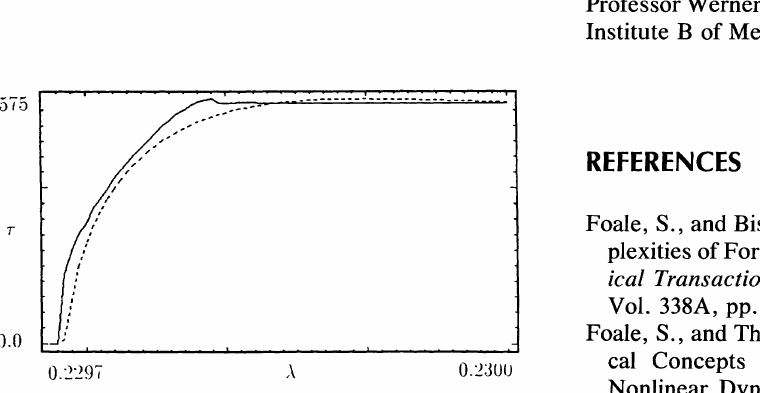
FIGURE 2 The test functions in tracing a P-1 orbit (-) CPLO model and (---) smoothed